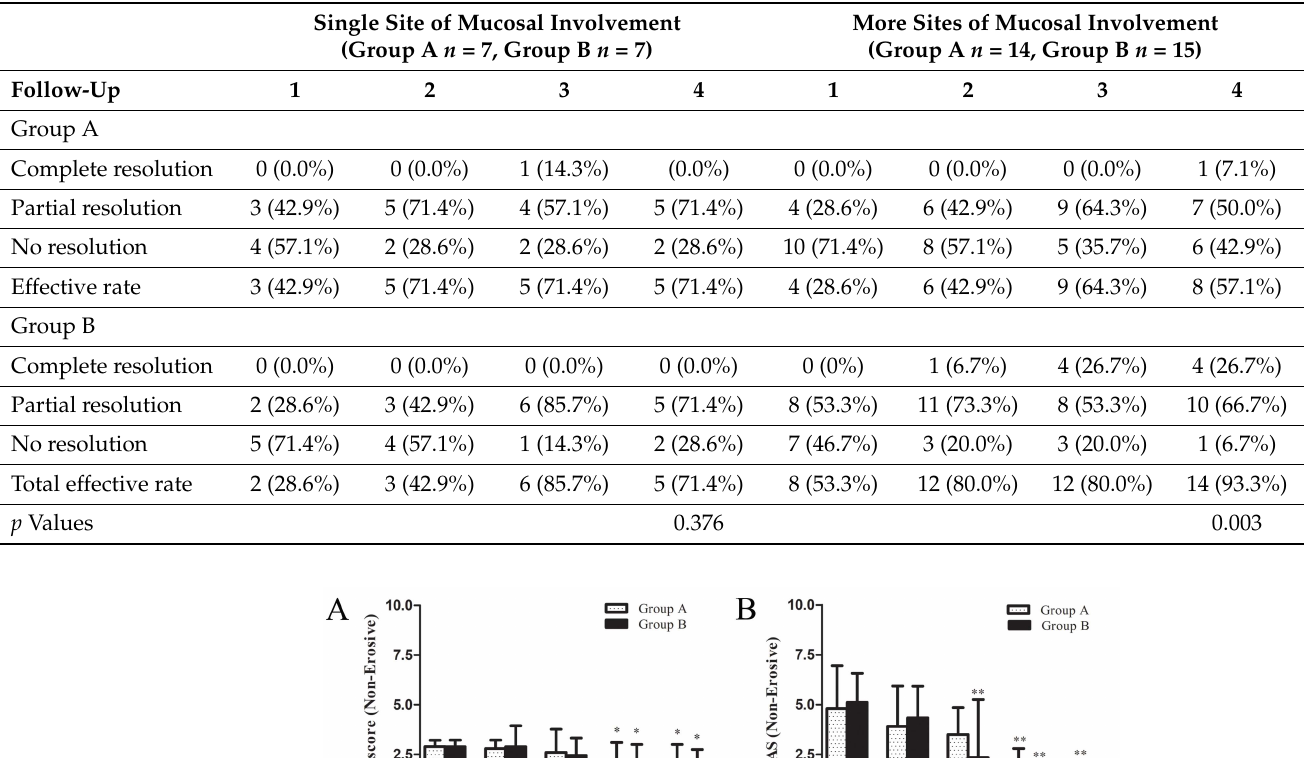
Table 5. Comparison of the treatment effective rate between groups with different sites of mucosal involvement.